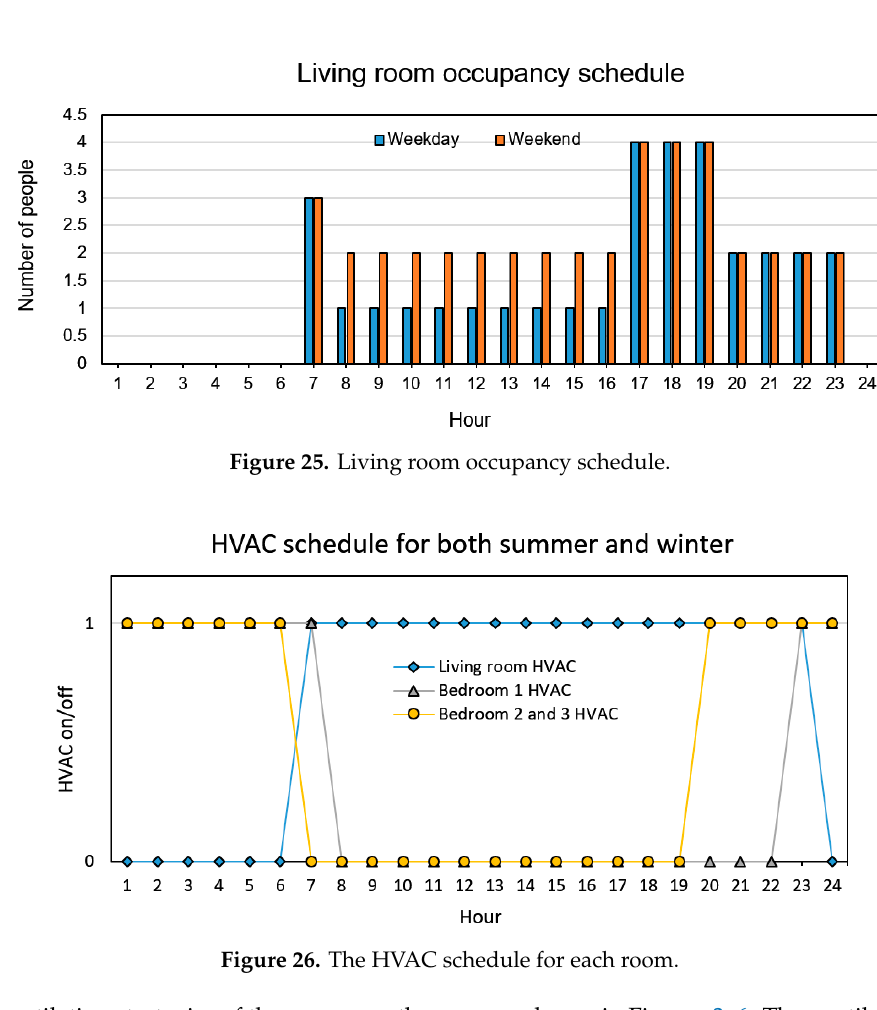
Figure 26. The HVAC schedule for each room.